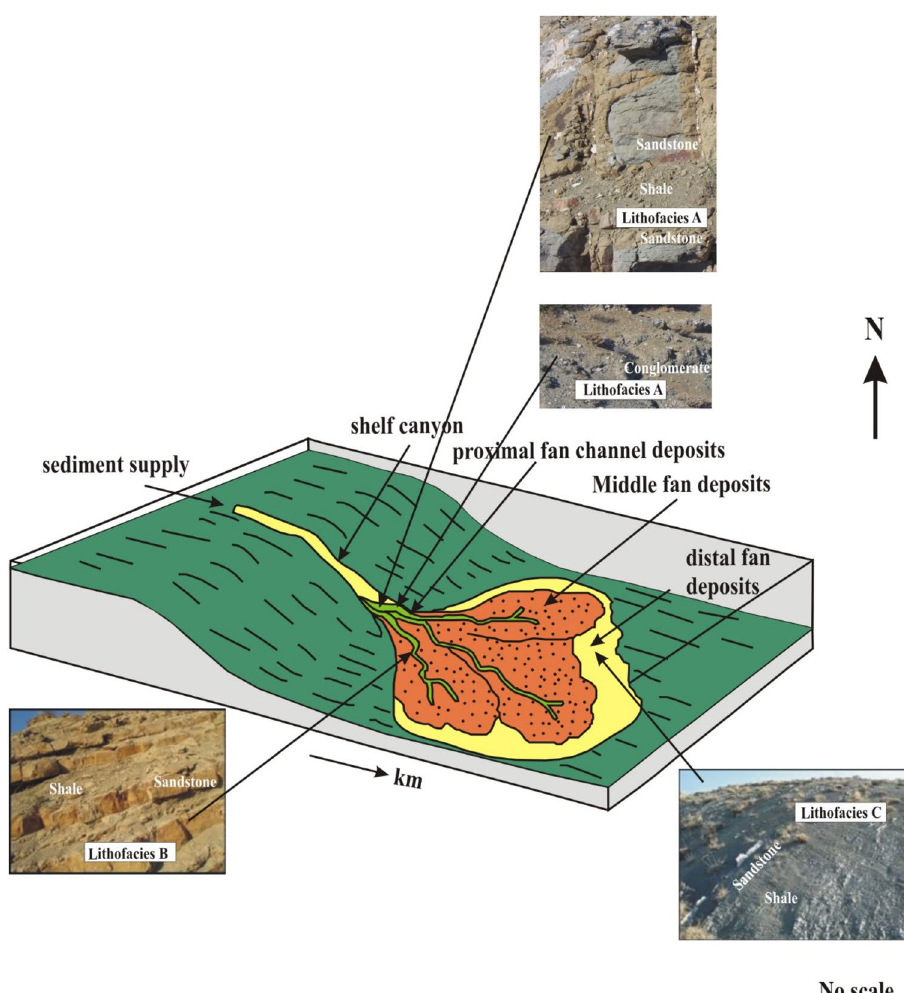
Fig. 4 Depositional environ- ments of the Haymana Forma- tion submarine-fan